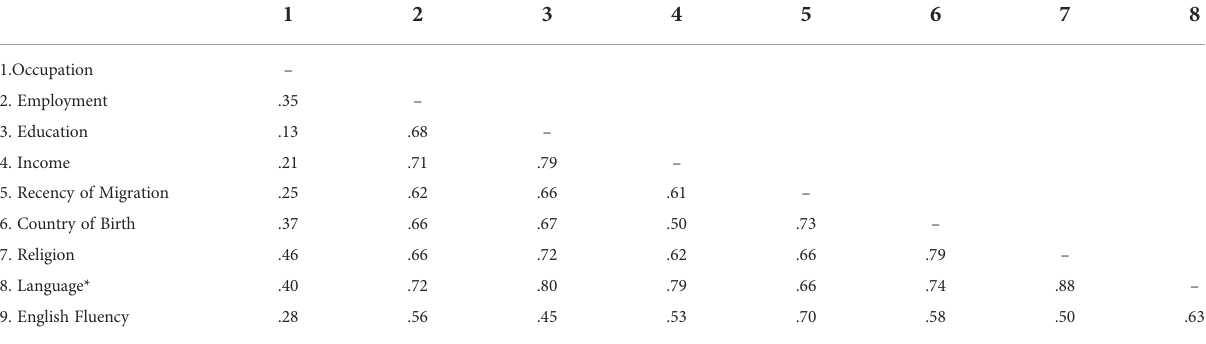
TABLE 2 Pairwise Pearson correlations between socio-economic and ethnocultural characteristics of areas, as related to breast screening